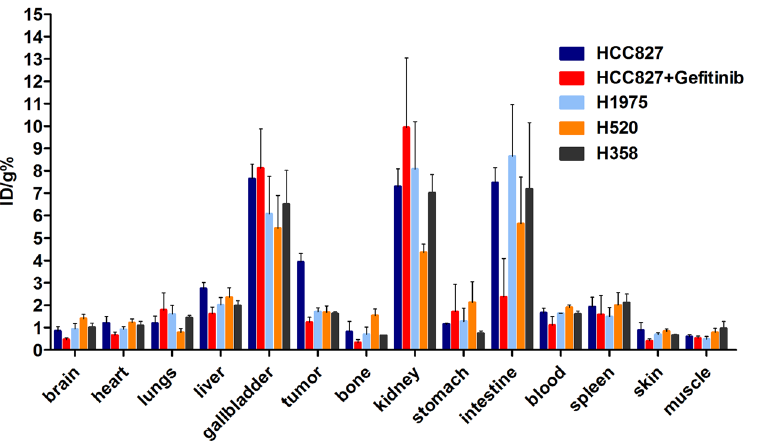
Figure 4. Ex vivo biodistribution of 18 F-IRS (3.7 MBq per mouse) in HCC827, HCC827 blocked by gefitinib, H520, H1975 and H358 tumor-bearing nude mice at 120 min after injection. Columns mean % ID/g (n = 4 per group); error bars indicate the mean ±